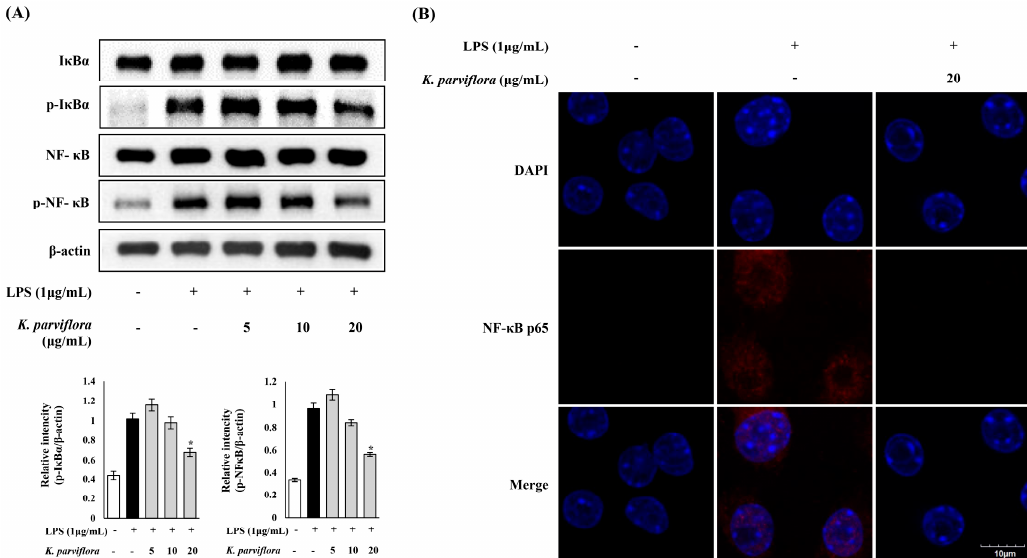
Figure 3. ( A ) Inhibitory effect of Kaempferia parviflora extract on the nuclear factor-kappa B (NF- κ B) signaling pathway in LPS-stimulated RAW 264.7 cells, examined by western blotting. The expressions of p-I κ B α and p-NF- κ B were analyzed with ImageJ and normalized against β -actin. * p < 0.05 compared with LPS treated cells only; ( B ) effect of K. parviflora extract on the translocation of NF- κ B p65 in LPS-induced RAW 264.7 cells. Immunofluorescence staining for NF- κ B p65 (red) in LPS-exposed RAW 264.7 cells without and with 20 µ g/mL K. parviflora extract. Nuclei are stained with 4,6-diamidino-2-phenylindole dihydrochloride (DAPI) (blue). K. parviflora extract reduced the nuclear translocation and accumulation of NF- κ B p65, which was induced by LPS. Scale bar = 10 μ m.